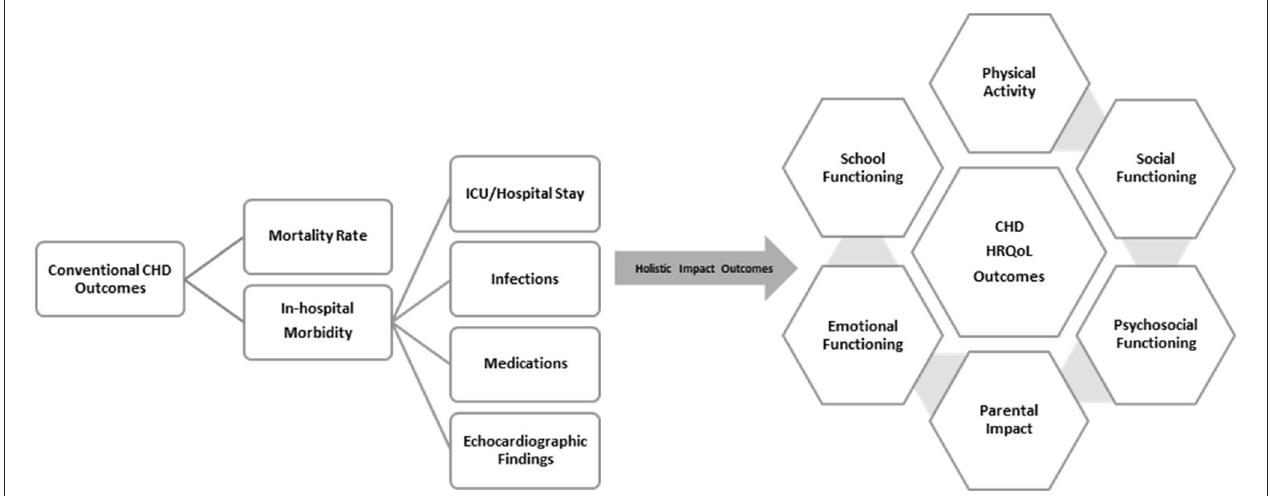
FIGURE 2 | Conventional vs. Holistic health outcomes in CHD; HRQoL, Health related quality of